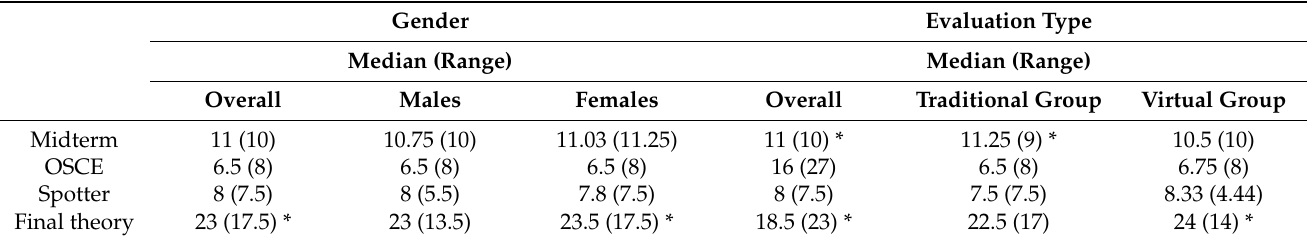
Table 4. Difference in scores of students in terms of gender and evaluation type.